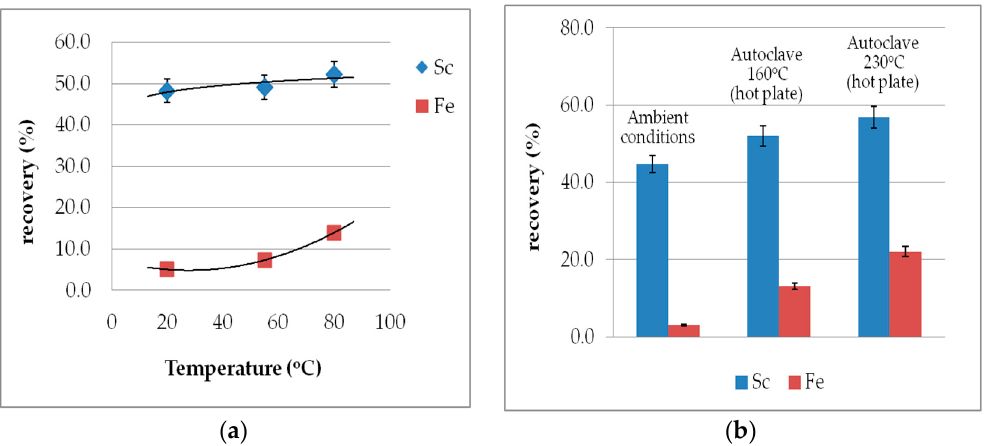
Figure 5. Effect of temperature on Sc and Fe recovery ( a ) under normal pressure and ( b ) under autoclave conditions (S/L 10%, 2 M H 2 SO 4 , t = 60 min).